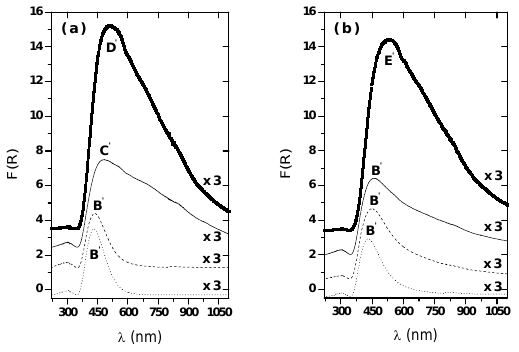
Fig. 3 – DRS spectra after successive treatment cycles; – ( · · ·· ) oxidation, ( ) reduction, ( — ) reduction +3% H 2 O/He at 673K, ( - - - - ) reduction +3% H 2 O/5% O 2 /He at 673K. (a) PdCe-Cl e (b)